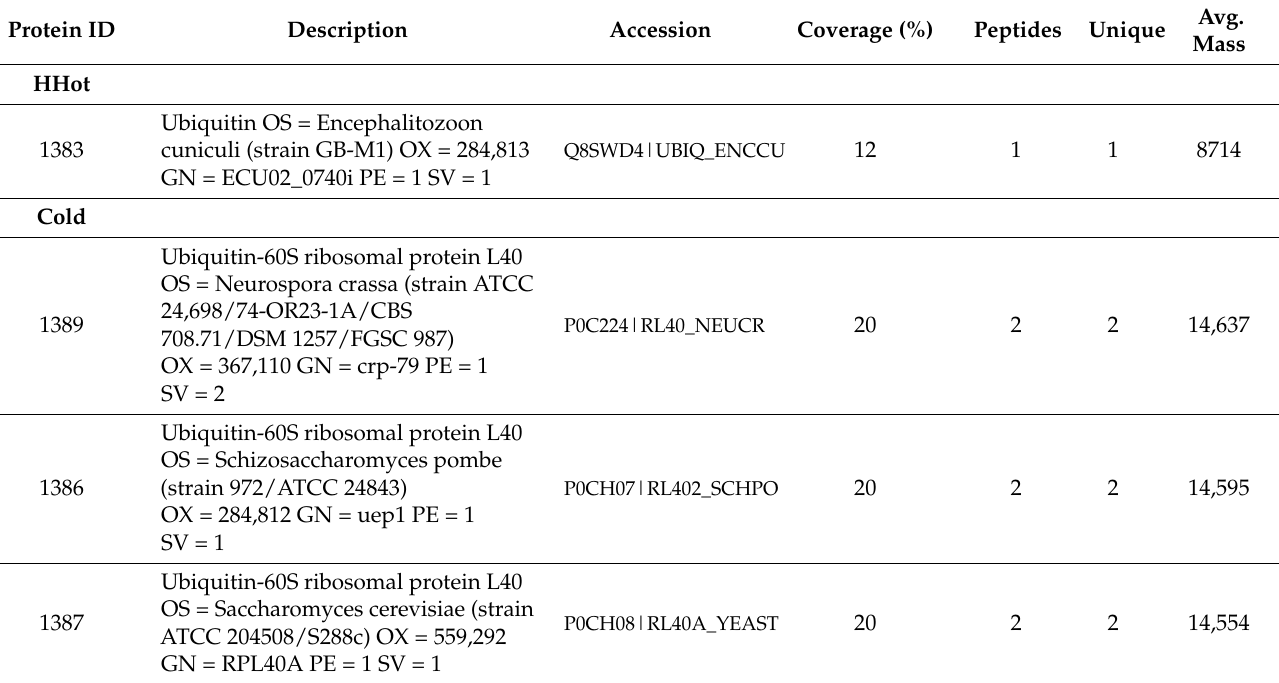
Table 3. Results of “hot” and “cold” AuNPs without incubation with plasma, which were used as controls. As mentioned above, results were compared against the UniProt fungi protein database. Description Accession Coverage (%) Peptides Unique